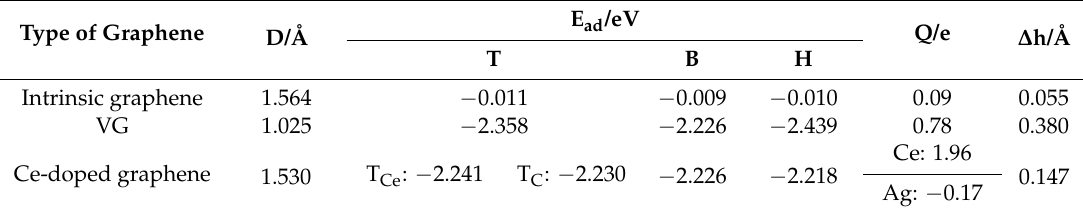
Table 1. The final adsorption distance ( D ) and adsorption energy ( E ad ) of three bonding sites: top (T), bridge (B), and hollow (H), and charge transfer ( Q ) and deformation ( ∆ h = h max − h average ) after the adsorption of the Ag atom on